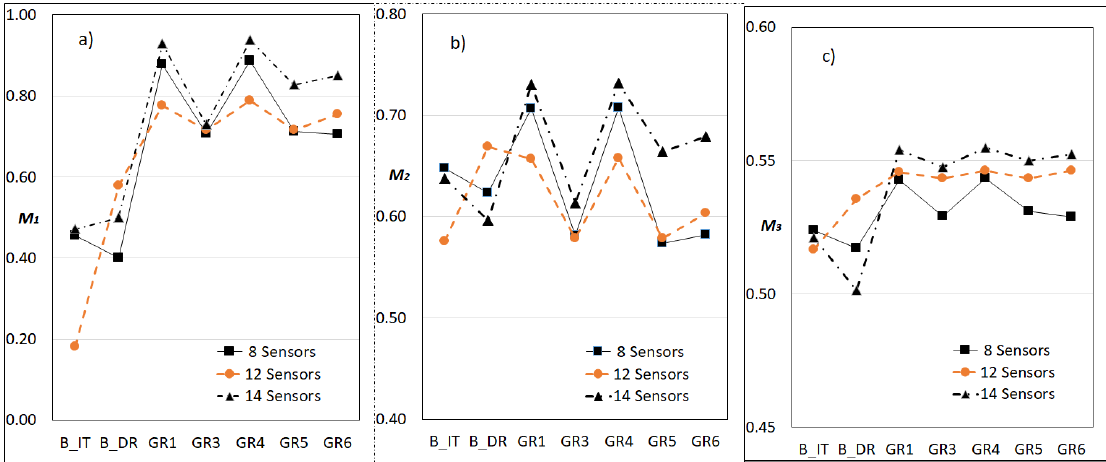
Figure 3. Indicator values of the different procedures with 8, 12 and 14 sensors. ( a ) M 1 : equations (15) and (16); ( b ) M 2 : equations (15)–(17); ( c ) M 3 : equations (15)–(18).